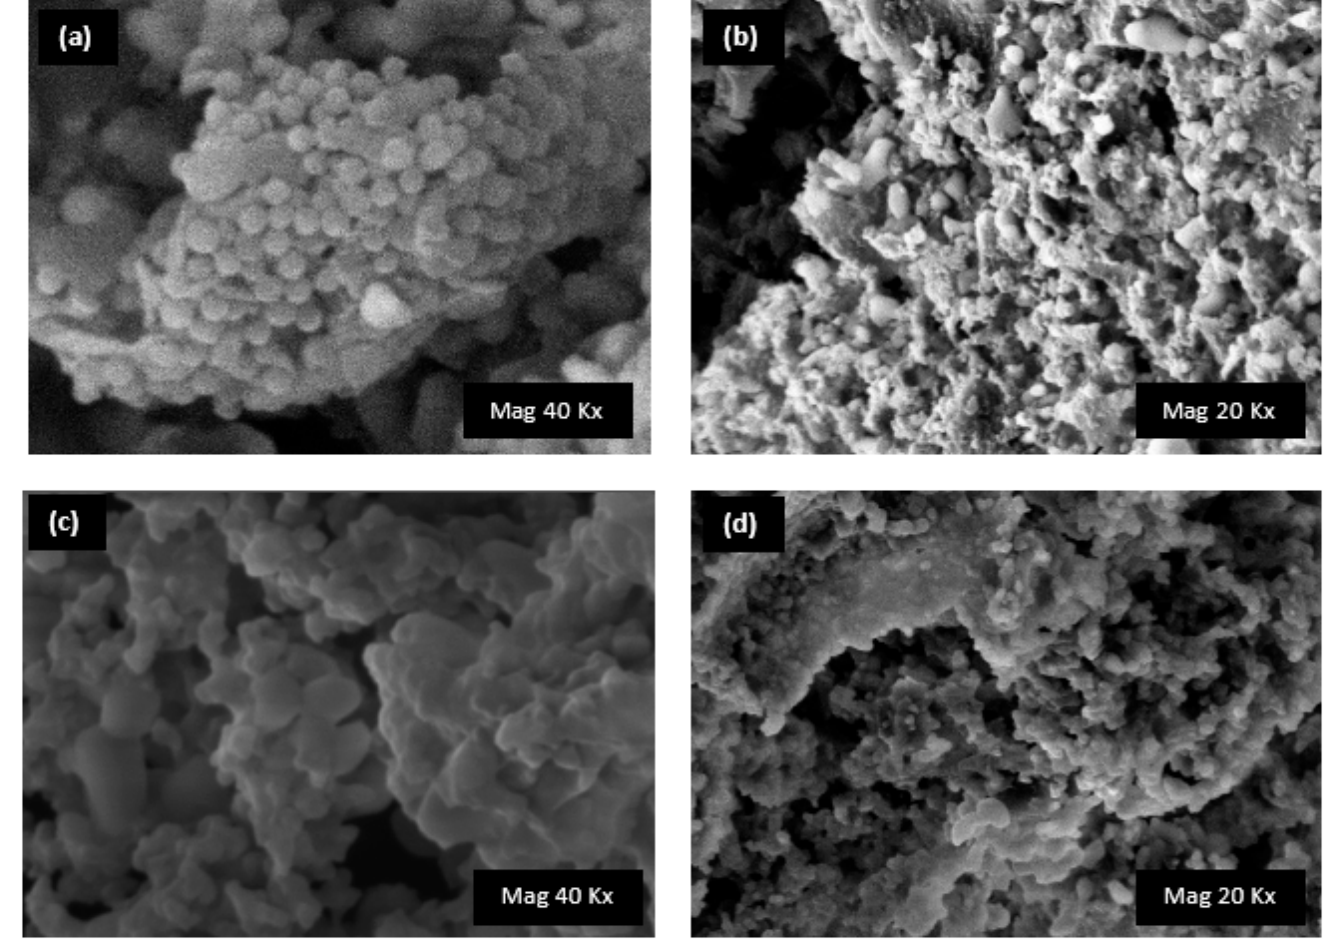
Figure 7. SEM images of ( a ) blank β -CD PYRO (1:4), ( b ) RK-loaded β -CD PYRO (1:4), ( c ) blank LC PYRO (1:4), and ( d ) RK-loaded LC PYRO (1:4).